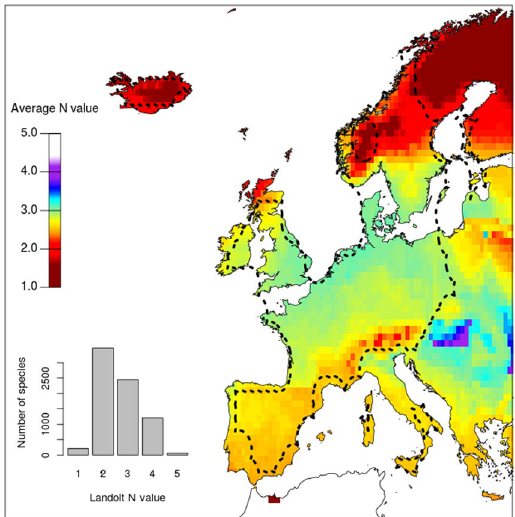
Figure 5. Mean Landolt N nutrient values of the flora across Europe based on the distribution of 6046 species. A low nutrient value indicates that a species is oligotrophic, while a high value indicates a preference for richer soils. The black line delimits the zone in which we estimated that over 50% of the flora was included (see methods and Figure S2) and was calculated with an alpha-hull ( α = 1.5). The histogram shows the distribution Landolt N values for 7394 species within the overall European species pool. The map was generated using R3.4.2 (https://cran.r-project.org) 68 . The coastline data was downloaded from the US National Centers for Environmental Information 69